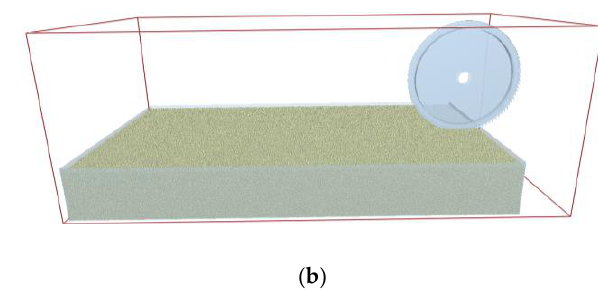
Figure 7. Particle and geometric simulation model. ( a ) Particle model of the soil; ( b ) simulation model of the EDEM.